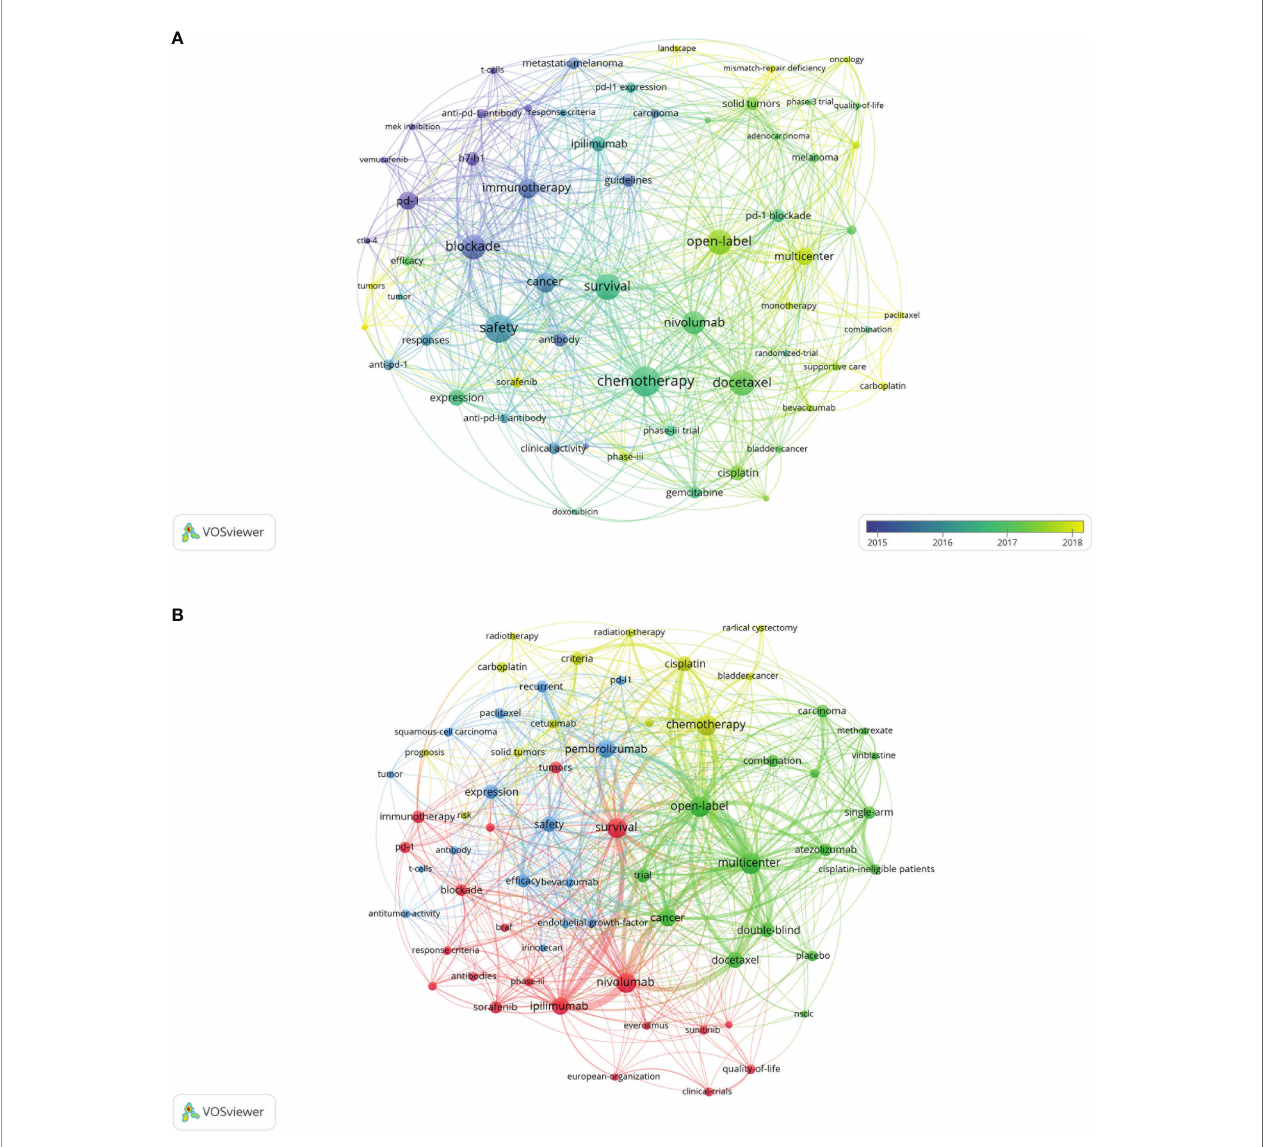
FIGURE 5 | (A) Network visualization of keywords from the 100 most cited papers according to the average year of publication. (B) Network visualization of keywords from papers published in major journals from 2020 to 2021 according to cluster analysis. The circle size represents the number of articles included in the 100 most cited articles; the width of the curved line represents the link strength; and the distance between two keywords approximates the relatedness of the nodes. NSCLC, non-small cell lung